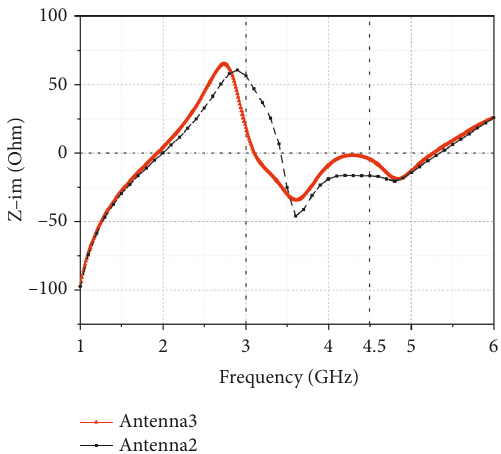
Figure 4: Reflection coefficients of antenna 1 vs. antenna 2.